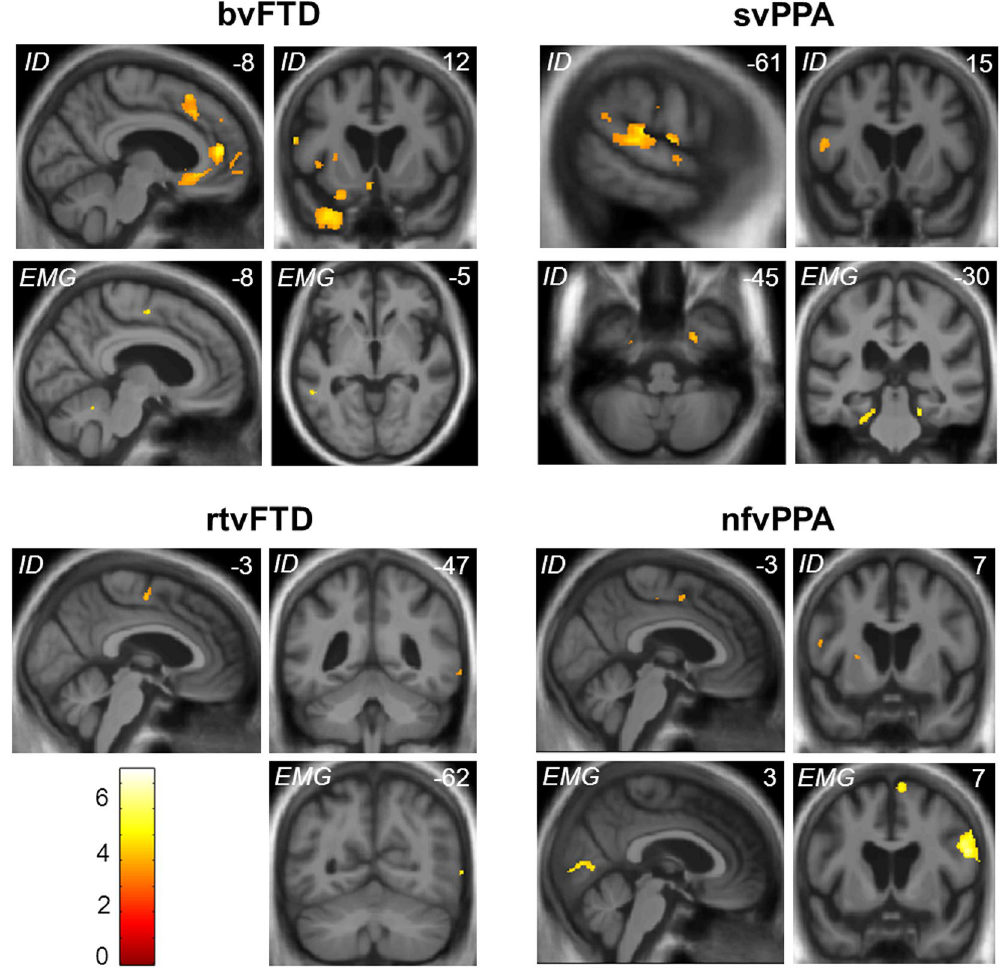
Figure 3. Neuroanatomical correlates of emotion identification and EMG reactivity for each syndromic group. Statistical parametric maps (SPMs) show regional grey matter volume positively associated with overall emotion identification accuracy and facial EMG reactivity during viewing of emotional facial expressions, based on voxel-based morphometry of patients’ brain MR images (see also Table 3); T-scores are coded on the colour bar. SPMs are overlaid on sections of the normalised study-specific T1-weighted mean brain MR image; the MNI coordinate (mm) of the plane of each section is indicated (coronal and axial sections show the left hemisphere on the left). Panels code syndromic profiles of emotion identification ( ID ) or EMG reactivity ( EMG ). Note that the correlates of emotion identification and EMG reactivity in different syndromes overlapped in particular brain regions, including supplementary motor cortex and temporo-occipital junction (see Table 3). SPMs are thresholded for display purposes at p < 0.001 uncorrected over the whole brain, however local maxima of areas shown were each significant at p < 0.05 after family-wise error correction for multiple voxel-wise comparisons within pre-specified anatomical regions of interest (see Table 3). bvFTD, patient group with behavioural variant FTD; nfvPPA, patient group with nonfluent variant primary progressive aphasia; rtvFTD, patient subgroup with right temporal variant frontotemporal dementia; svPPA, patient group with semantic variant primary progressive